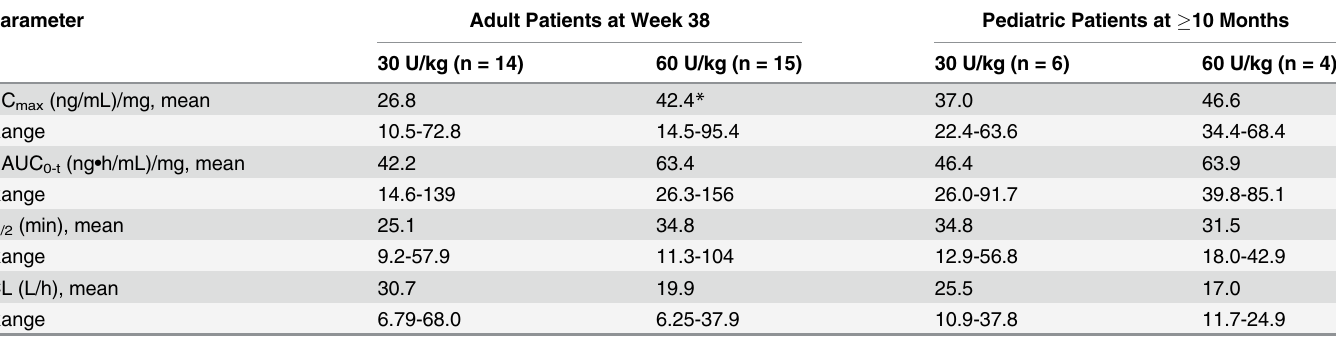
Table 4. Comparative summary of PK parameters for taliglucerase alfa following multiple-dose intravenous infusion of 30 or 60 U/kg in adult and pediatric patients with Gaucher